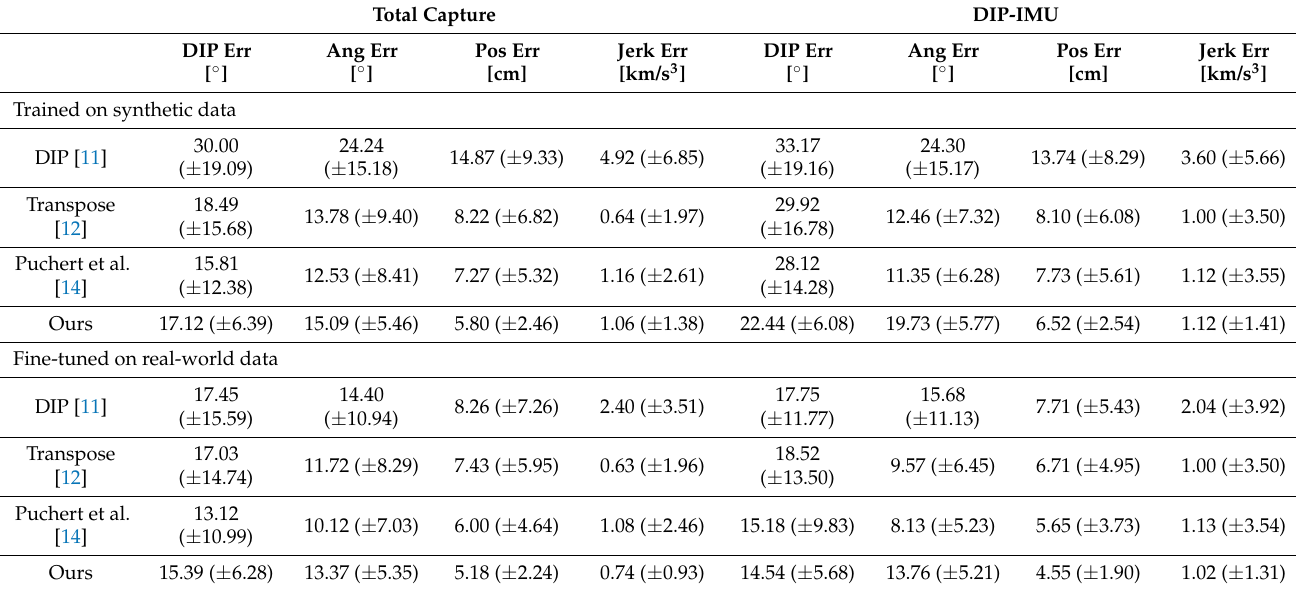
Table 1. Evaluation of our network model. Comparison with state-of-the-art and comparable methods on the DIP-IMU and Total Capture datasets. The evaluation metrics include the hip and shoulder global angle error (DIP Err) and the mean global angle, mean position, and mean jerk errors for all 15 key